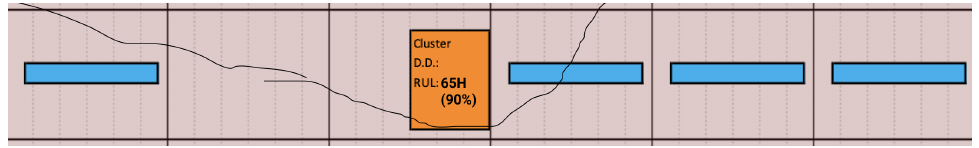
Figure 9. Proposed impact curve by Participant